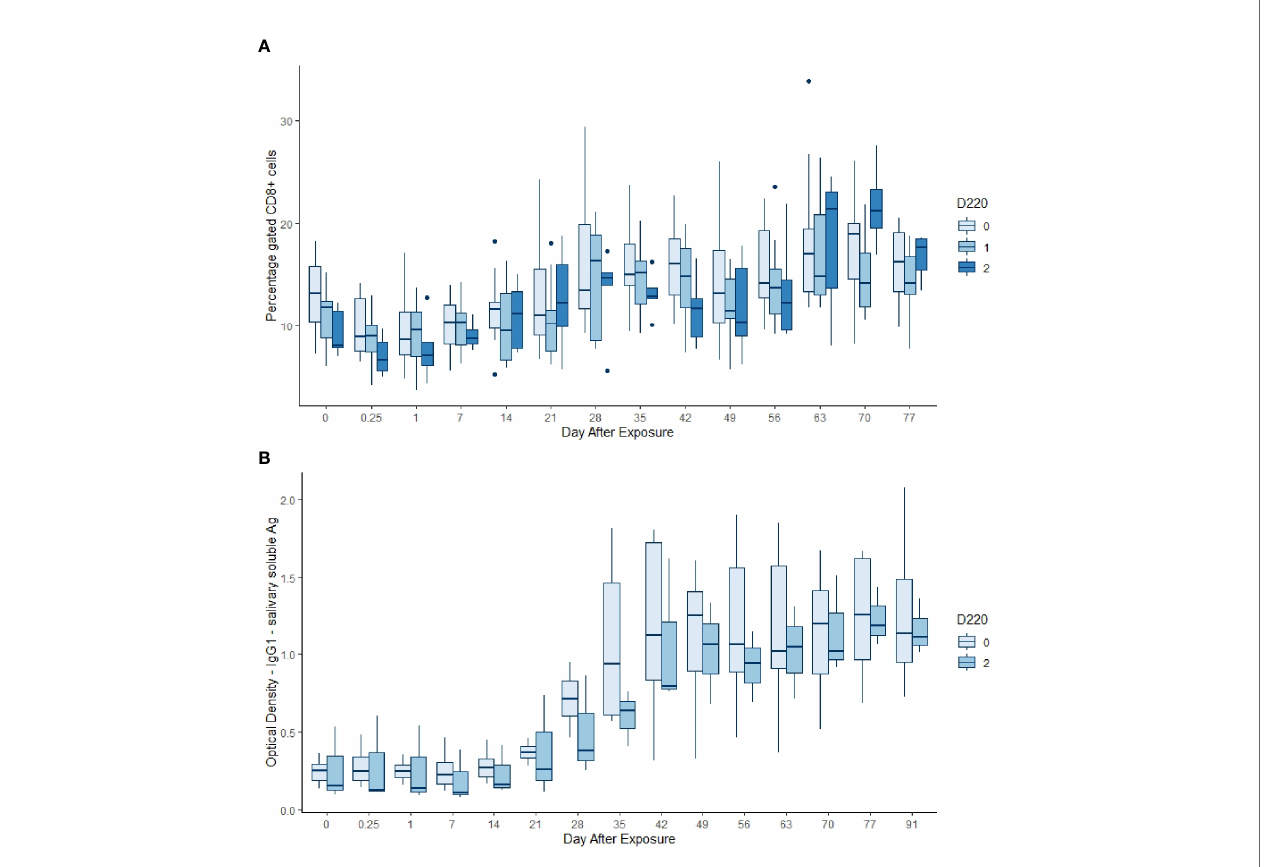
FIGURE 5 | (A) Gated percentage of CD8+ cells by day, commencing pre-infestation and continuing for 11 weeks. Data for the 220 allele are shown, those animals without the allele in palest blue, and animals that were 220/220 in the darkest blue. Both day and the allele dose were highly signi fi cant in the GAM ( p < 0.00083, Table 5 ). (B) IgG1 optical density (OD) in response to soluble salivary tick Ag by day, commencing pre-infestation and continuing for 15 weeks. Data for the 220 allele are shown and those animals without the allele (pale blue) are all 462/462 (dark blue). Both day and the genotype were highly signi fi cant terms in the GAM ( p < 0.00083, Table 5